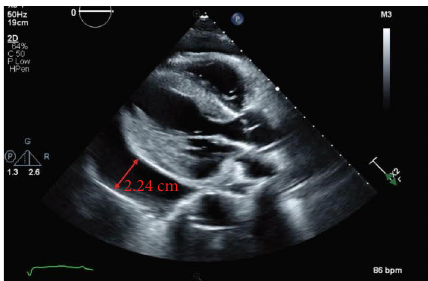
Figure 2: Initial transthoracic echocardiogram obtained on ad- mission shows a large circumferential pericardial efusion mea- suring 2.24cm (red line). Cardiac tamponade is present, evinced by early right ventricular diastolic collapse, signifcant respirophasic variation of mitral infow and IVC dilation with decreased re- spiratory variation consistent with elevated right atrial